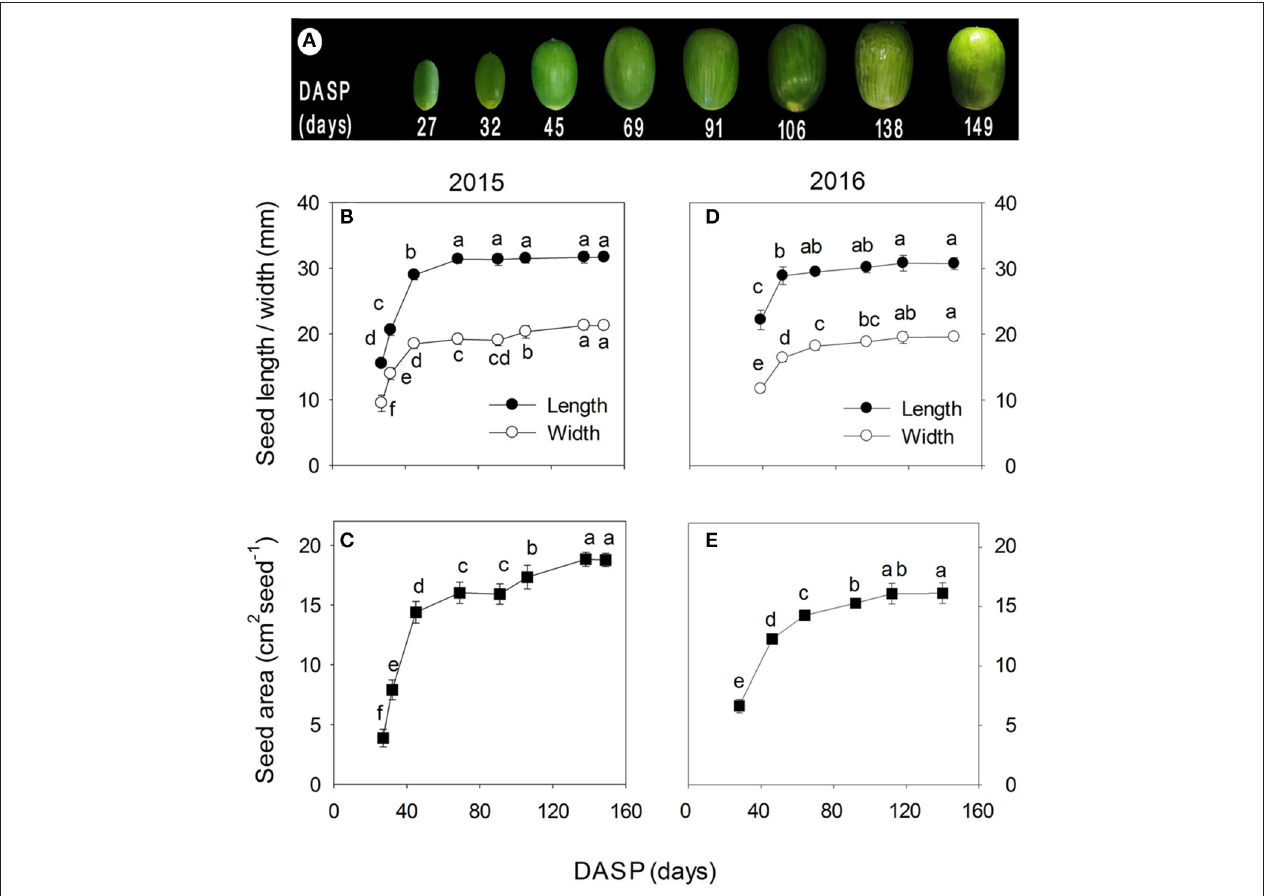
FIGURE 2 | Seed development in Torreya grandis cv. “Merrillii” in 2015 and 2016, as indicated by the color (A) , the length and the width (B,D) , and the area (C,E) of the seeds. In (B–E) the mean ± SD is indicated. Different letters denote significant differences at P ≤ 0.05 level. n = 4 trees. DASP, days after seed